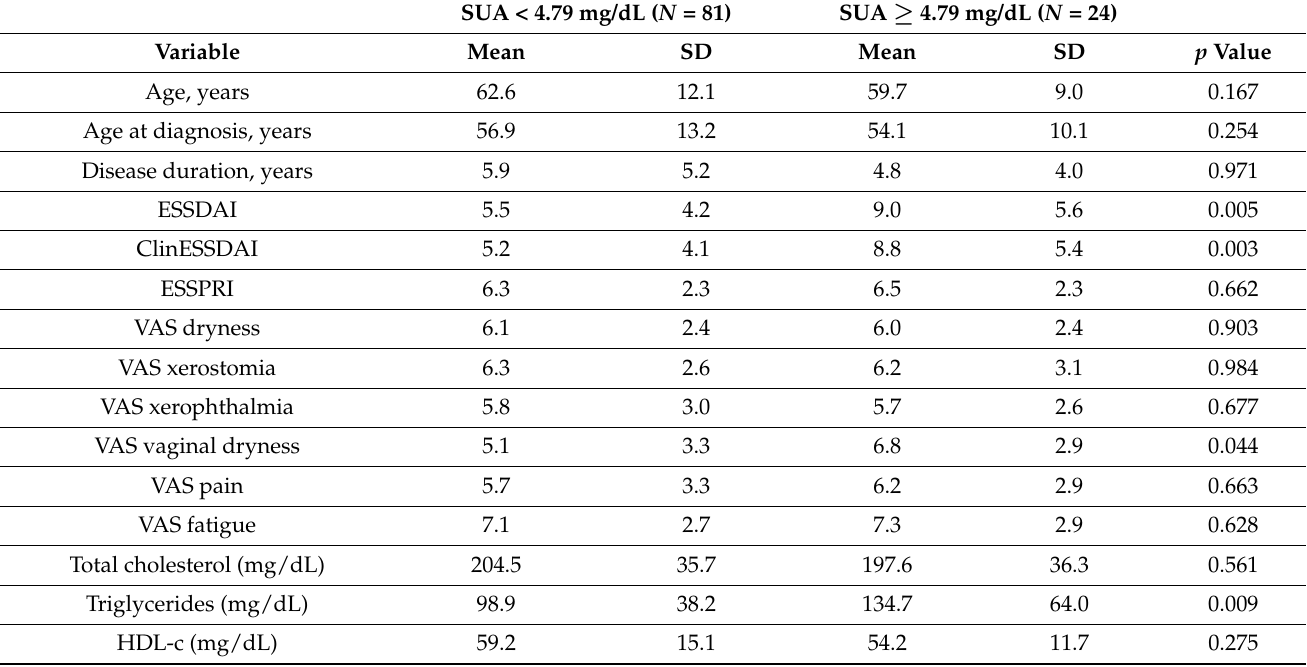
Table 2. Characteristics of the study cohort ( N = 105) according to serum uric acid